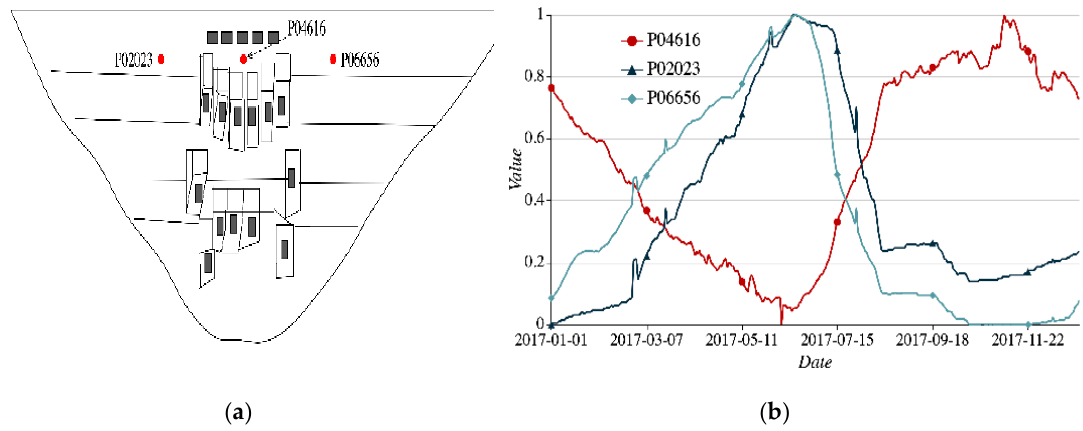
Figure 6. Spatial-temporal feature of nodes P04616, P02023, and P06656 ( a ) spatial distribution of three nodes; ( b ) sequential process lines of three nodes. nodes; ( b ) sequential process lines of three